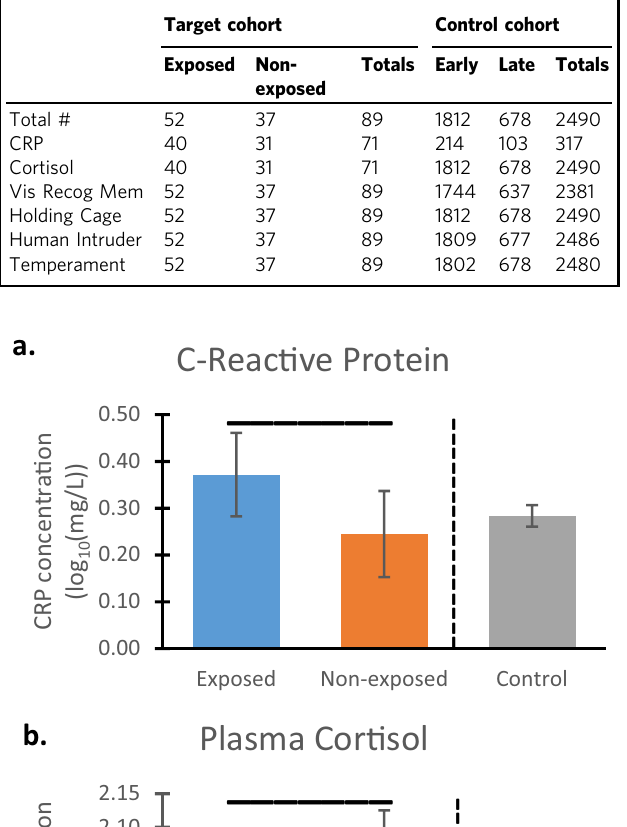
Table 1 Sample sizes for all statistical analyses.